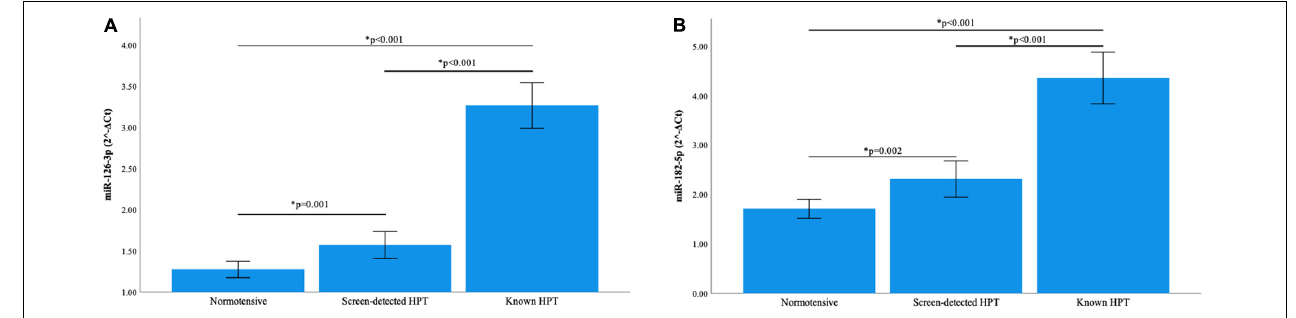
FIGURE 1 | Comparison of the relative expression of miR-126-3p and 182-5p in the three blood pressure groups. (A) The expression of miR-126-3p was significantly higher in known hypertensives when compared to screen-detected hypertensives ( p < 0.001) and the normotensives ( p < 0.001). There was also a significant difference in expression when screen-detected hypertensives were compared to the normotensives ( p = 0.001). (B) There was a significantly higher expression of miR-182-5p in known hypertensives when compared to screen-detected hypertensives ( p < 0.001) and the normotensives ( p < 0.001). When screen-detected hypertensives were compared to the normotensives, that significant difference in expression remained ( p = 0.002). The relative miRNA expressions were calculated using the 2 – (cid:49) Ct method and a one-way ANOVA used to compare differences in miRNA expression between groups. The symbol * denotes a statistically significant p